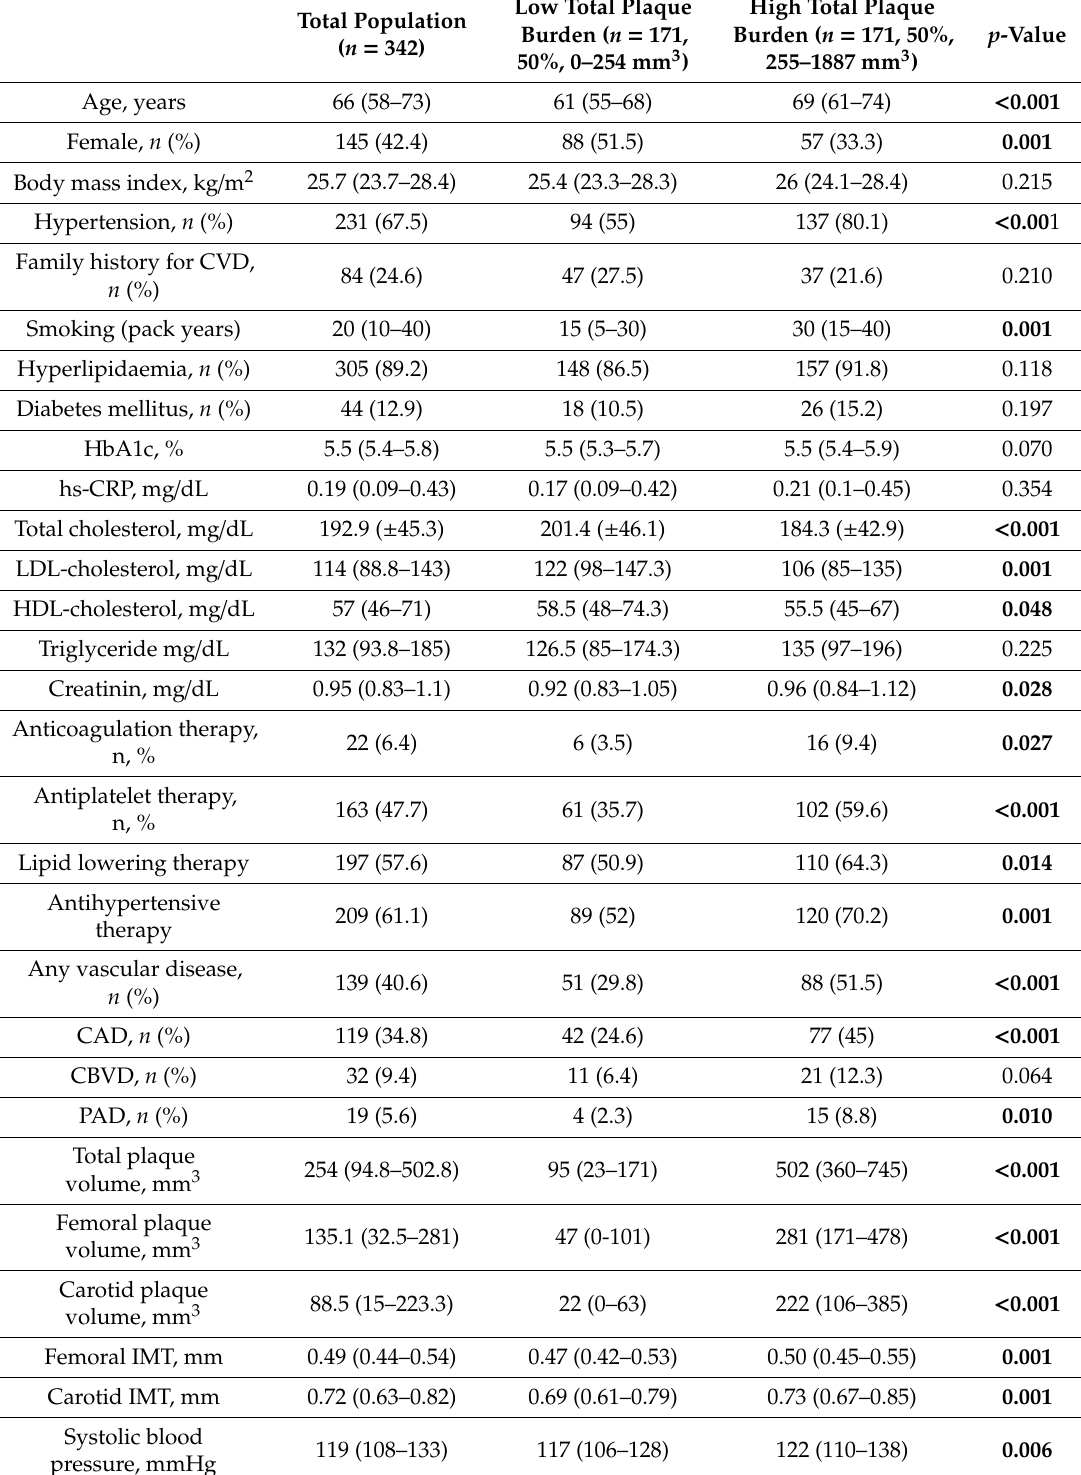
Table 1. Characteristic of the study